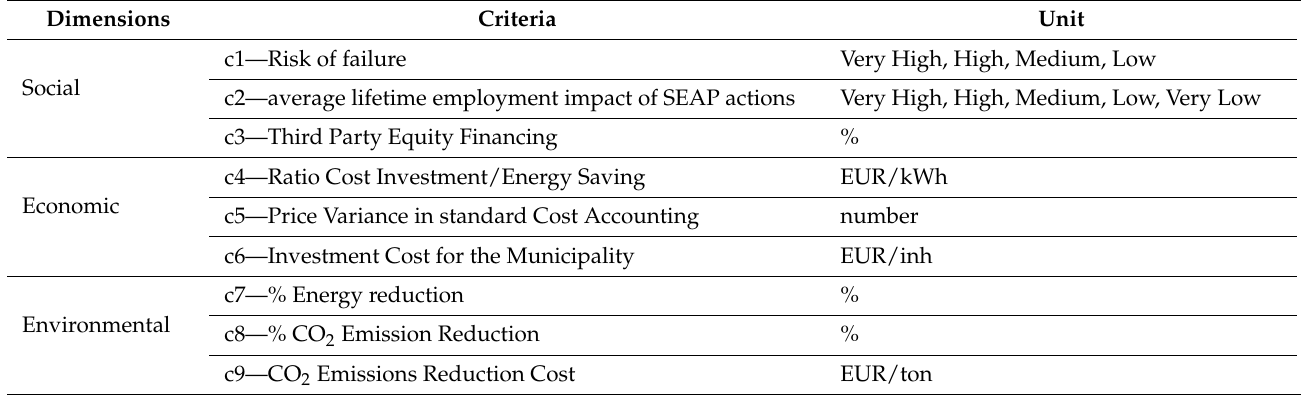
Table 1. Selected Criteria.